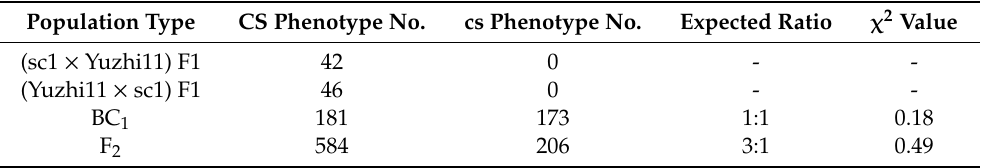
Table 1. Inheritance analysis of the Sc and sc1 phenotypes in sesame.